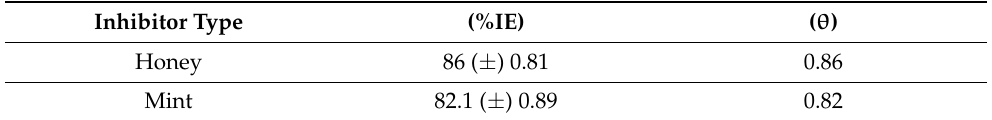
Table 6. IE and fractional surface coverage values ( θ ) were gained using a weight loss technique for aluminum in an aqueous solution of 1 M HCl for two hours in the absence and presence of different concentrations of honey as the inhibitor. The standard deviation is shown by the ( ± ) sign, and these numbers represent the average of three